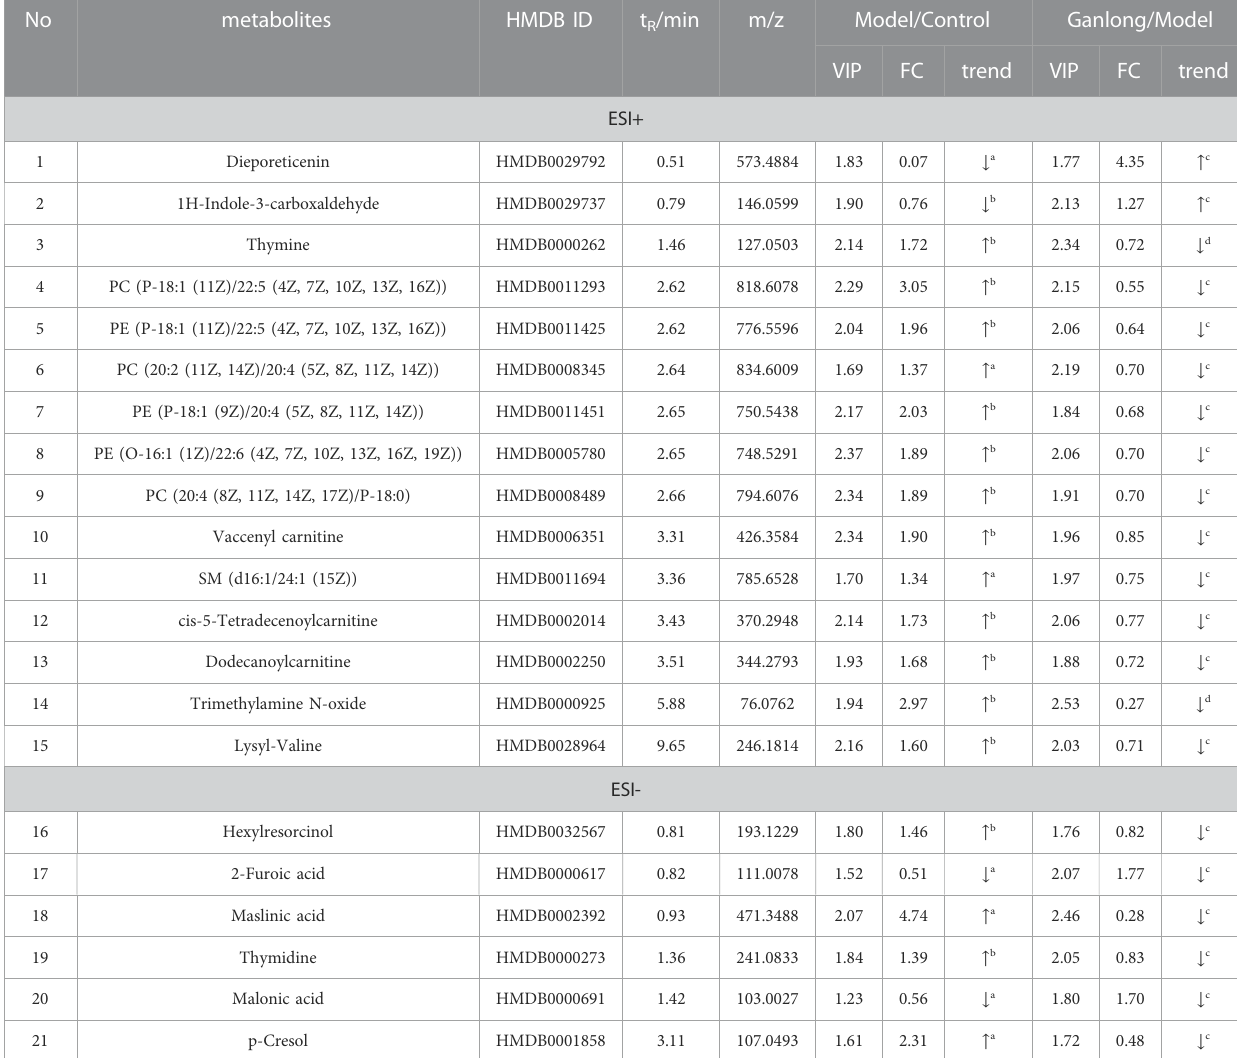
TABLE 3 Summary of the differential metabolites identi fi ed in the serum of three Groups. No